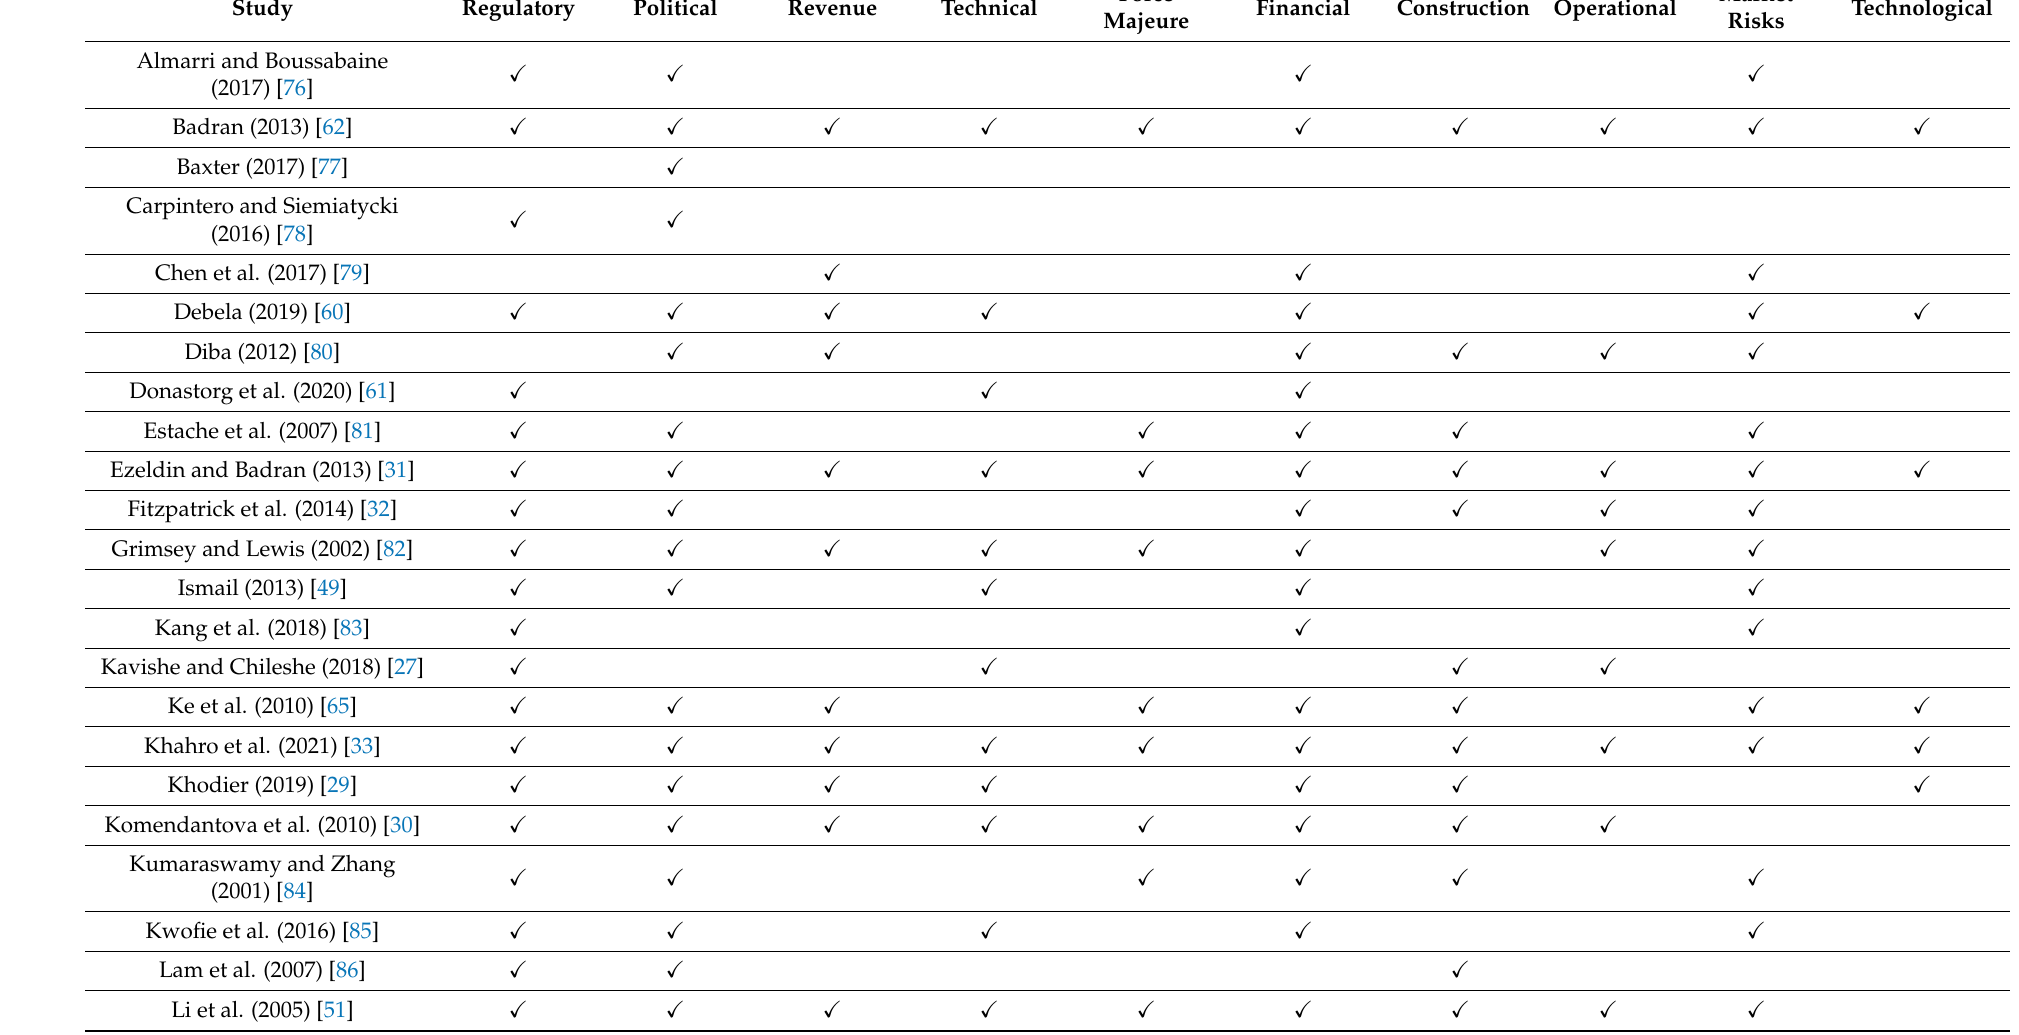
Table A2. Main barriers investigated in the different studies in the